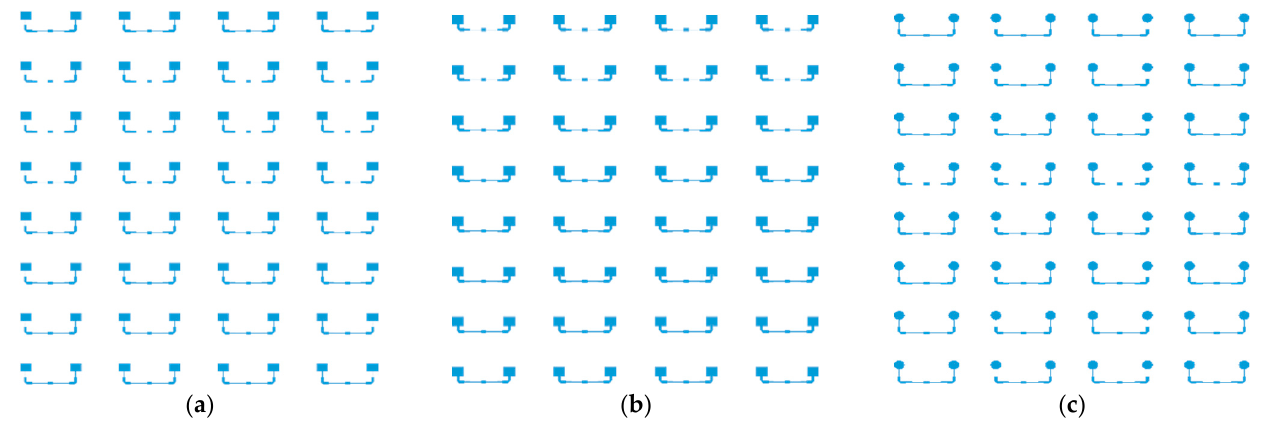
Figure 9a–c show the arrays of 32 ports for each type of designed antenna. These arrays were the largest ones that were simulated in each case.